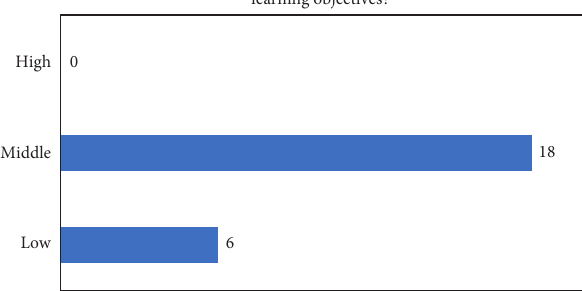
Figure 4: The effectiveness of the initiative implementation.